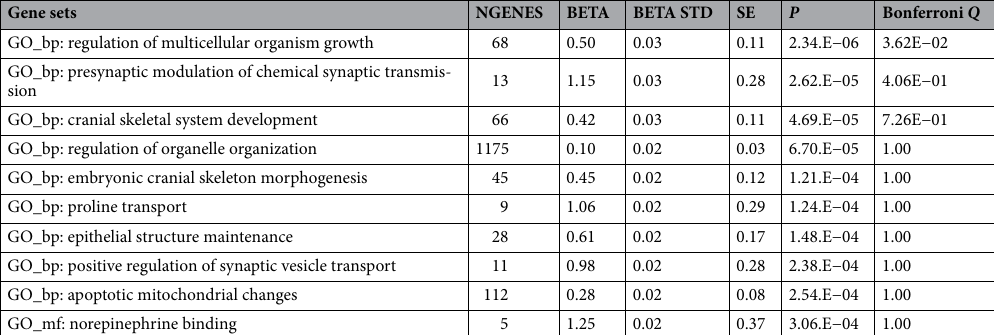
Table 4. Top ten ranked pathways associated with skeletal muscle mass. For MAGMA analysis, 15,480 gene sets (curated gene sets, 5497; gene ontology terms, 9983) from MsigDB v7.0 were used. GO gene ontology, GO_bp GO biological process, GO_mf GO molecular function, NGENES the number of genes in the data that was in the set, BETA the regression coefficient of the variable, BETA STD the semi-standardized regression coefficient, corresponding to the predicted change in Z-value given a change of one standard deviation in the predictor gene set/gene covariate (i.e., BETA divided by the variable’s standard deviation), SE the standard error of the regression coefficient, P p -value, Bonferroni Q Bonferroni adjusted q -value.